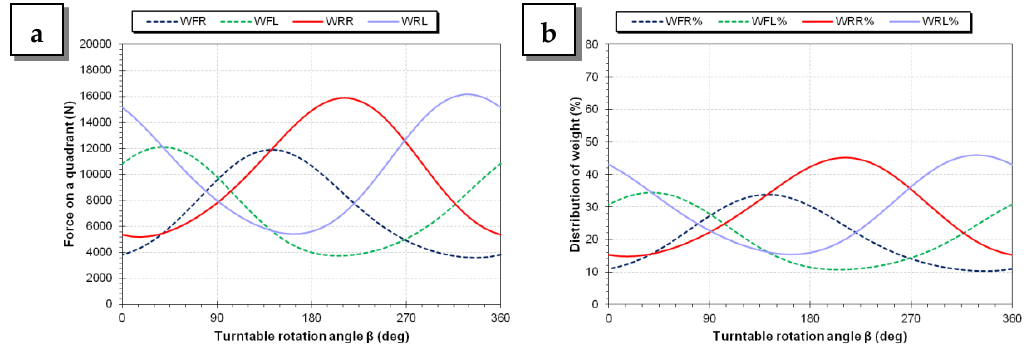
Figure 18. ( a ) forces normal to the four quadrants that support the vehicle during a complete rotation of the turntable for α = 20.00 ◦ ; ( b ) percentage decomposition of the total weight on the four quadrants / wheels for α = 20.00 ◦ .